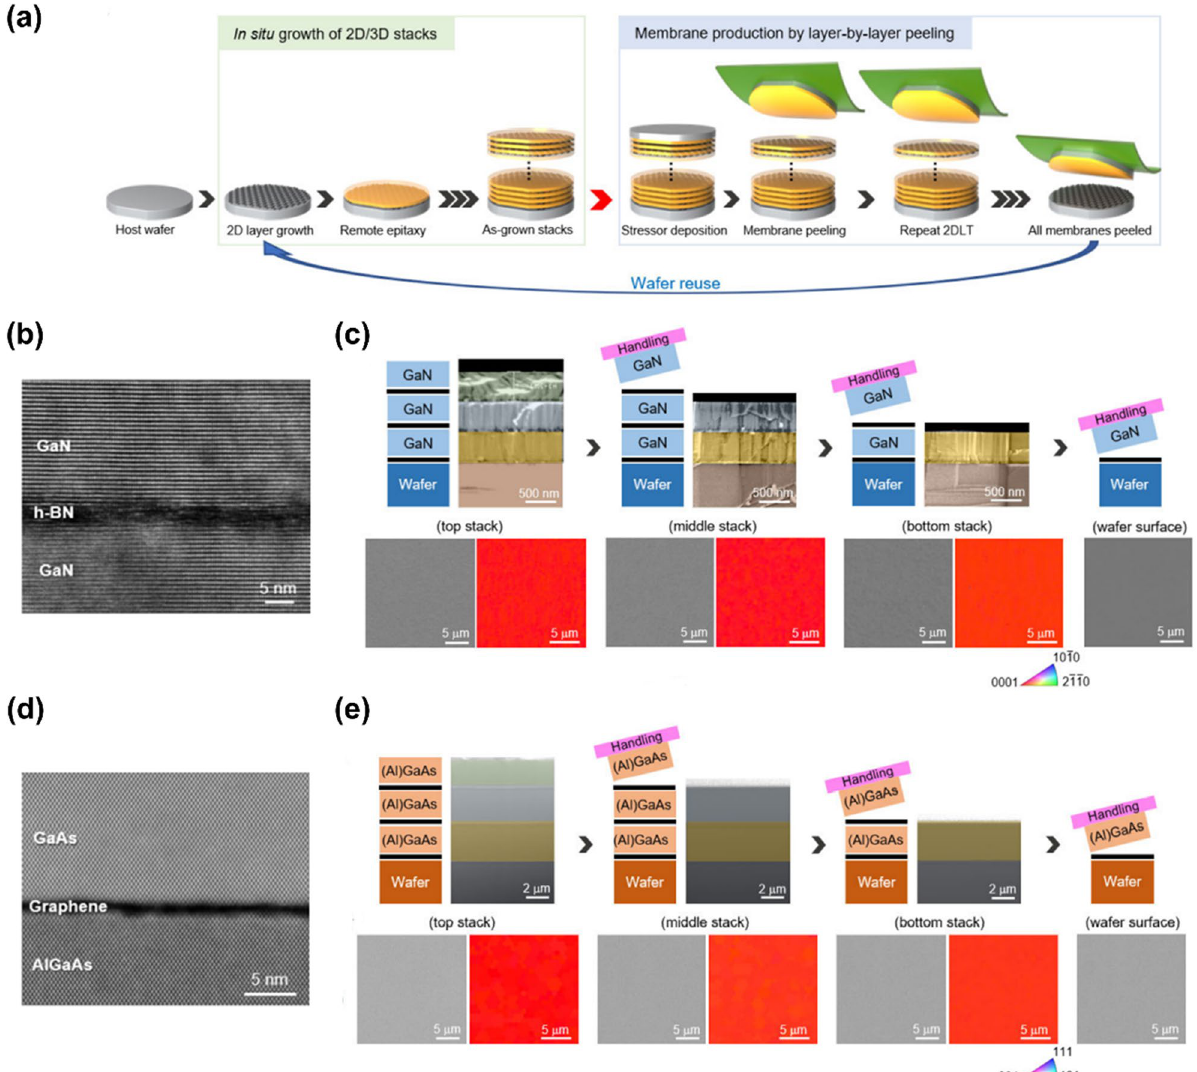
Fig. 3 Multiplication of freestanding membranes via in situ growth a The schematic illustration of membrane production process via in situ growth. b Cross‑sectional TEM image of remote epitaxially grown GaN on h‑BN/GaN. c False‑color cross‑sectional, Plan‑view SEM and EBSD map of as‑grown and after exfoliated GaN. d Cross‑sectional STEM image of remote epitaxially grown GaAs on graphene/AlGaAs/GaAs. e False‑color